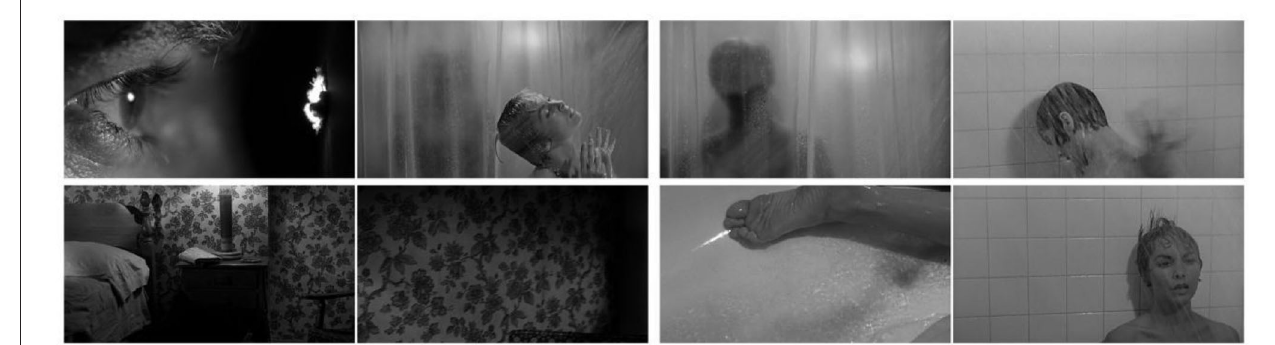
FIGURE 3 | The sample of video screenshots that were shown during fMRI scanning.